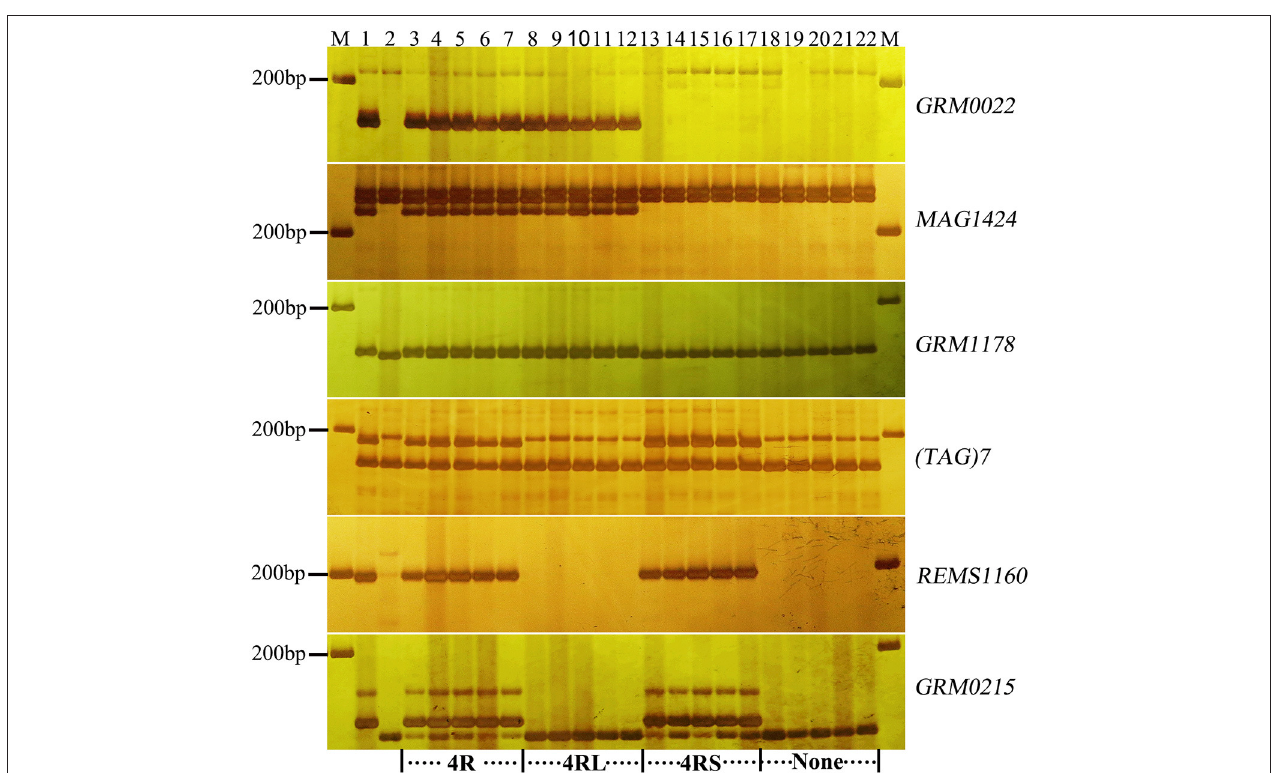
FIGURE 2 | Marker analysis of BC 2 F 2 plants segregating for 4R using rye-specific markers ( GRM0022 , MAG1424 , and GRM1178 ) on the long arm of 4R chromosome and markers ( (TAG)7 , REMS1160 , and GRM0215 ) on the short arm of 4R chromosome. Ten plants (lane 3–12) resistant to powdery mildew at the seedling stage and 10 susceptible plants (lane 13–22) were analyzed. Lane 3–7 and 18–22 show plants with entire 4R and without 4R chromosome, respectively. Lane 8–12 and 13–17 signify the presence of 4RL and 4RS alone, respectively. Lane 1 and lane 2 signify the resistant parent (Sorento) and susceptible parent (Xuezao),